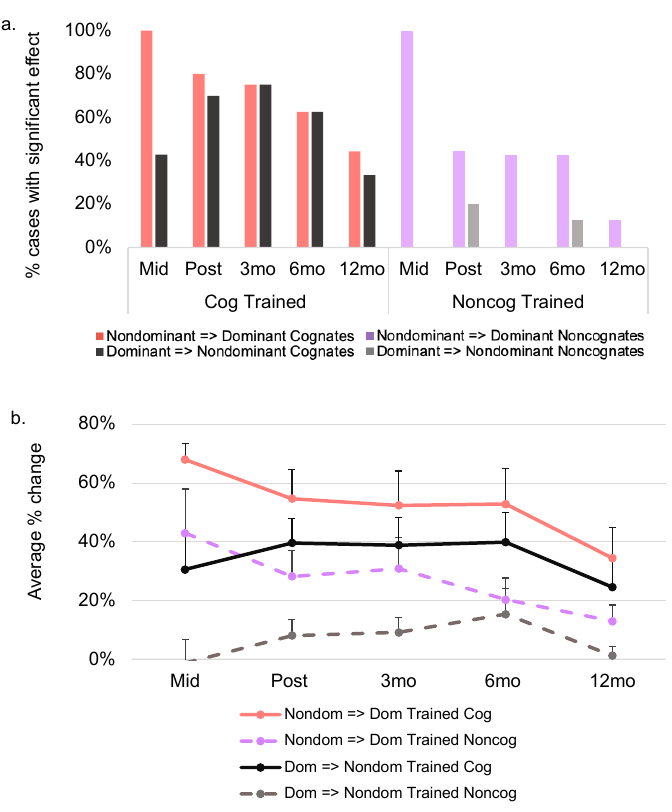
Figure 4. Cross-linguistic transfer effects by cognate status at each time point relative to pre-treatment. ( a ). Depicts the percentage of cases demonstrating a significant effect at each time point relative to pre-treatment. ( b ). Depicts the average percent change at each time point relative to pre-treatment. Performance on trained items across languages represents translation effects. At mid-treatment, seven of nine participants had received treatment in their dominant language and three had received treatment in their nondominant language; the figure shows performance for these subsets at mid-tx for trained and untrained items. See Supplementary Materials for data at the single-subject level. Mid = mid-treatment; mo =